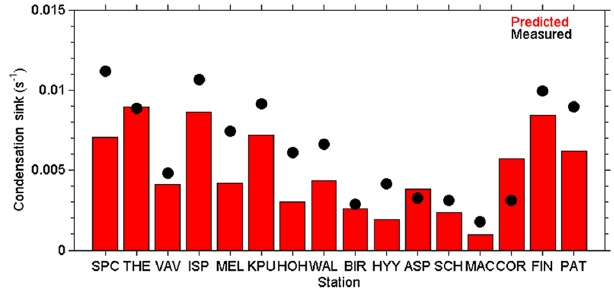
Figure 5. Average diurnal profiles of particle number concentra- tions (cm − 3 ) above 10nm in (a) Hyytiälä (Finland), (b) Melpitz (Germany), (c) San Pietro Capofiume (Italy), and (d) Thessaloniki (Greece) during 5 June–8 July 2012. Red lines correspond to pre- dictions and black symbols to observations.